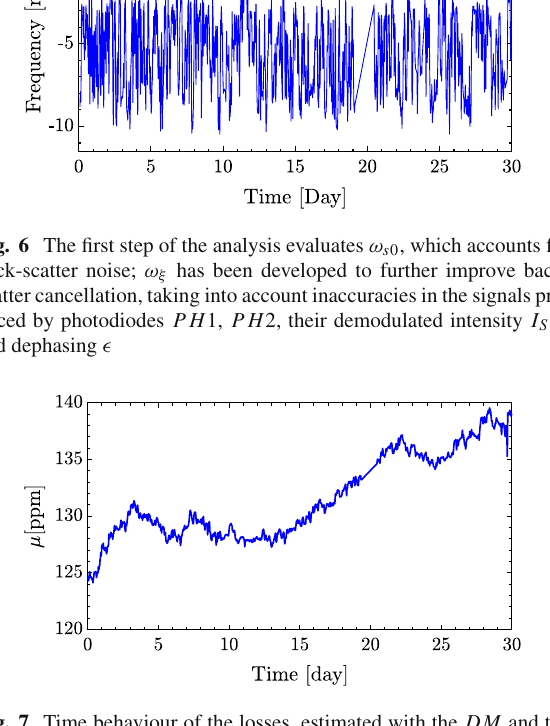
Fig. 7 Time behaviour of the losses, estimated with the DM and the uncontrolled mono-beam signal PH 2